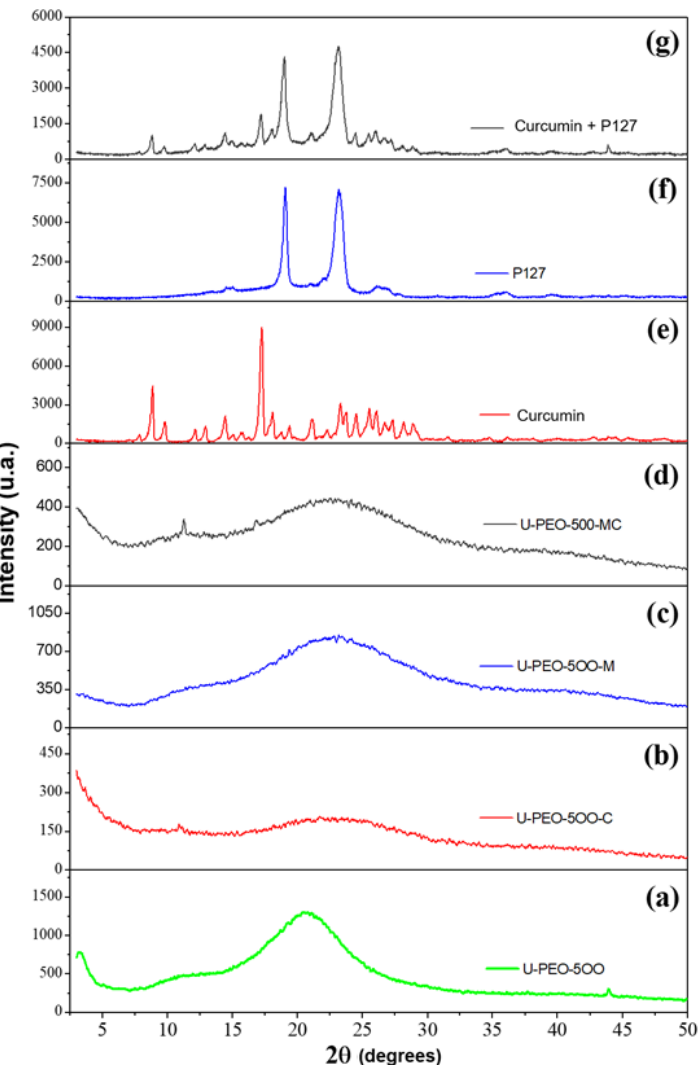
Figure 3. Sample XRD patterns: ( a ) pure U-PEO, ( b ) U-PEO + curcumin, ( c ) U-PEO + pure micelle, ( d ) U-PEO + micelle + curcumin, ( e ) pure curcumin, ( f ) pure micelle and ( g ) curcumin + micelle.